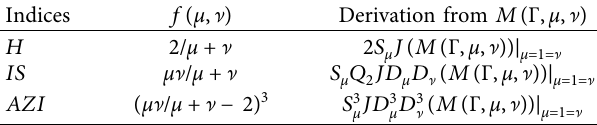
Table 3: Partition of edge set, VC